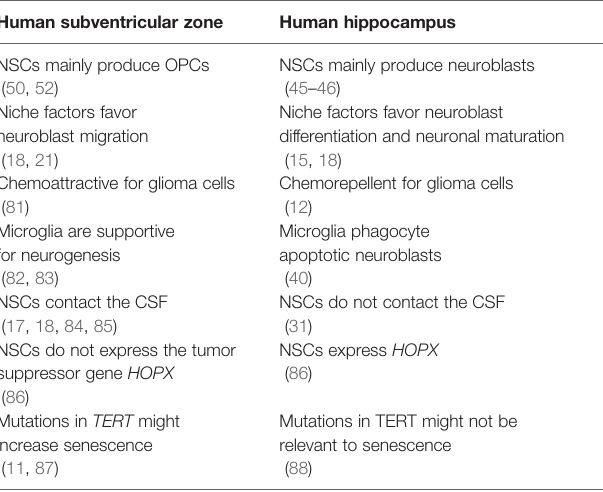
TABLE 2 | Analysis of possible factors determining why neural stem cells of the adult human subventricular zone might be more susceptible to malignant transformation than neural stem cells of the adult human